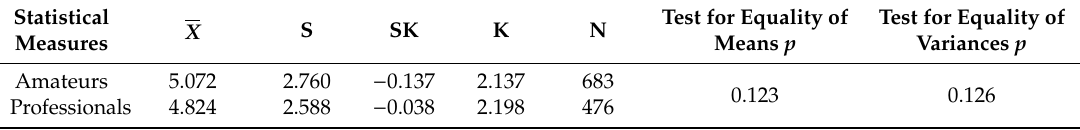
Table 7. Statistical measures of difficult access to a sports and recreation facility, in the opinion of